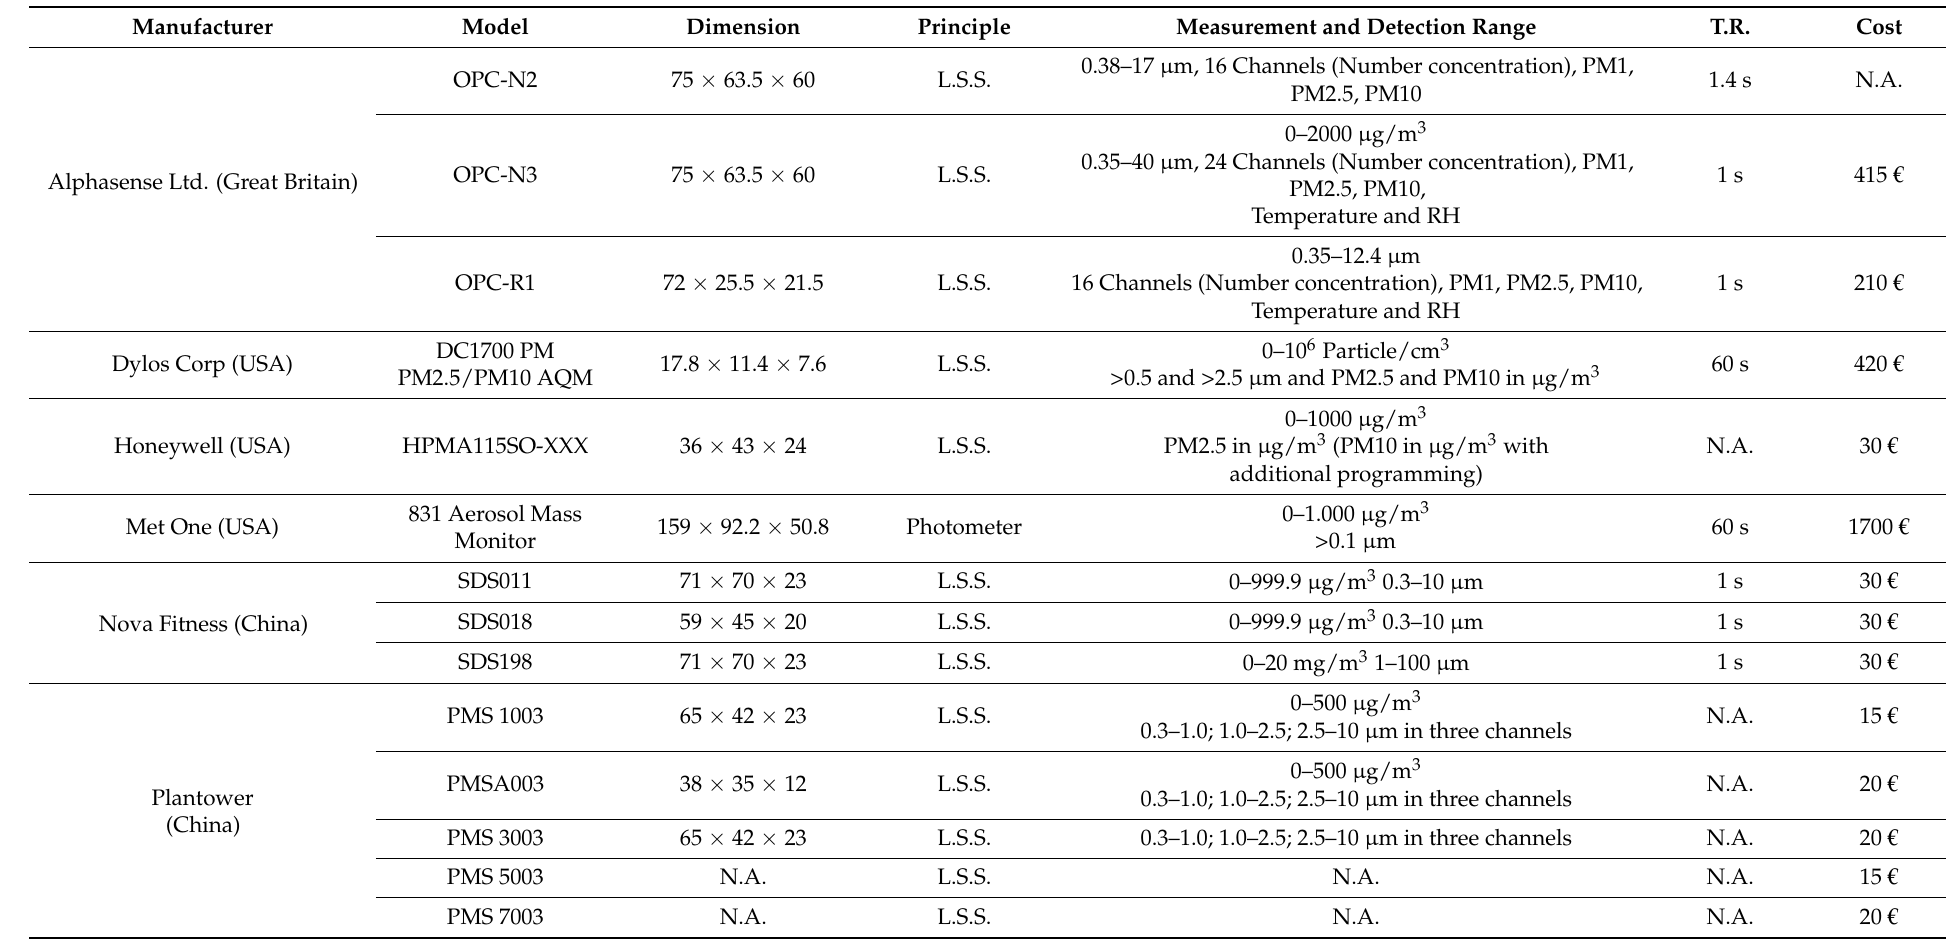
Table 1. List of low-cost PM sensors with the name of the manufacturer, model number, dimensions in mm, measurement principle used, the measurement and detection ranges, time resolution (T.R.), and the approximate